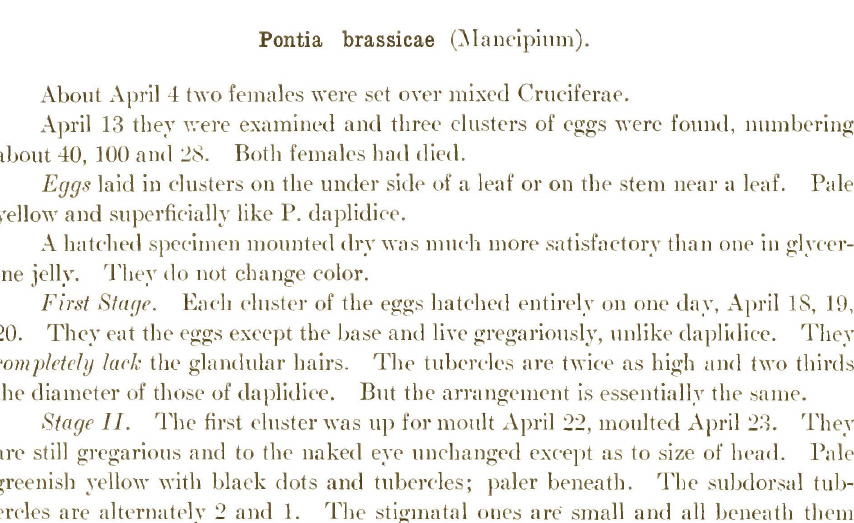
Tbc subdorsal tub